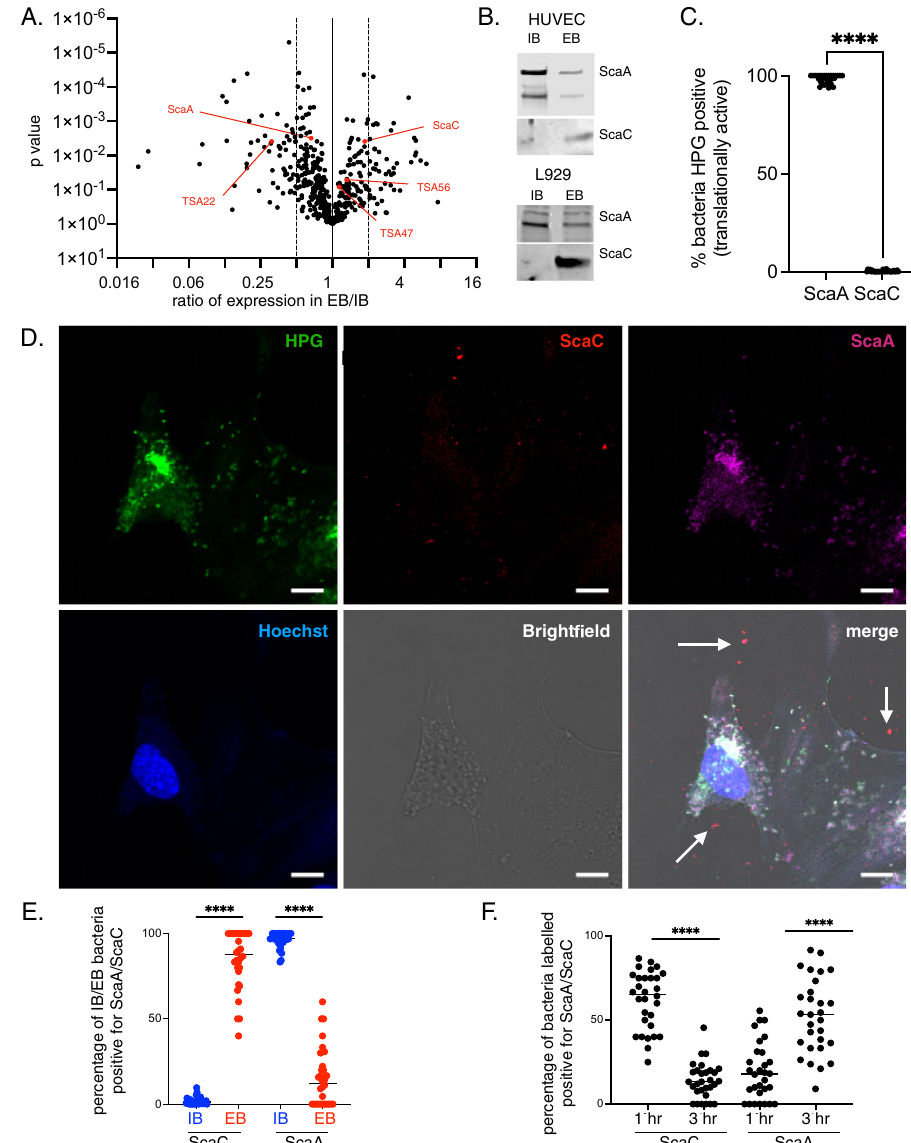
Fig. 4 Autotransporter proteins ScaA and ScaC are differentially expressed on IB and EB forms of Ot. A Volcano plot showing differential expression of surface proteins in proteomics analysis of IB and EB forms of Ot. We observe higher expression of ScaC, TSA56, and TSA47 in EB whilst IB Ot expresses higher ScaA and TSA22 levels. Statistical signi fi cance was determined using a t test. B Immunoblot analysis of IB and EB Ot from infected L929 and HUVEC cells con fi rming differential expression of ScaA, and ScaC between IB and EB forms. Loading was normalized by measuring bacterial genome copy number using qPCR. Uncropped immunoblot images with molecular weight markers are given in Supplementary Fig. 4. C Quanti fi cation of translational activity, as determined by a positive confocal microscopy signal observed with the clickable methionine probe HPG. HUVEC cells were infected with Ot for 5 days, then fi xed and labeled with HPG and anti-ScaA/anti-ScaC antibodies. ScaA/ScaC-positive bacteria were scored as being positive or negative for HPG labeling. D Confocal micrographs of HUVEC cells infected with Ot for 5 days and labeled for DNA (Hoechst, blue), translational activity (HPG, green), ScaA (anti-ScaA antibody, magenta), and ScaC (anti-ScaC antibody, red). Scale bar = 10 μ m. Examples of ScaC-positive extracellular bacteria are shown with a white arrow. More images and equivalent experiments in L929 cells are shown in Supplementary Figs. 5 – 7. E Quanti fi cation of experiments described in D . The percentage of IB and EB Ot at 5 days post-infection that were positively labeled with anti-ScaA and -ScaC antibodies was counted. F Quanti fi cation of ScaA- and ScaC- positive IB bacteria inside HUVEC cells one- and three hours post-infection, showing an increase in ScaA labeling and a decrease in ScaC labeling. In ( B , E , F ). n = 30 randomly imaged fi elds across three independent experiments. Graphs show individual values and means. Statistical signi fi cance was calculated using a two-sided unpaired t test with Graphpad Prism software. * p value ≤ 0.05; ** p value ≤ 0.01; *** p value ≤ 0.001; **** p value ≤